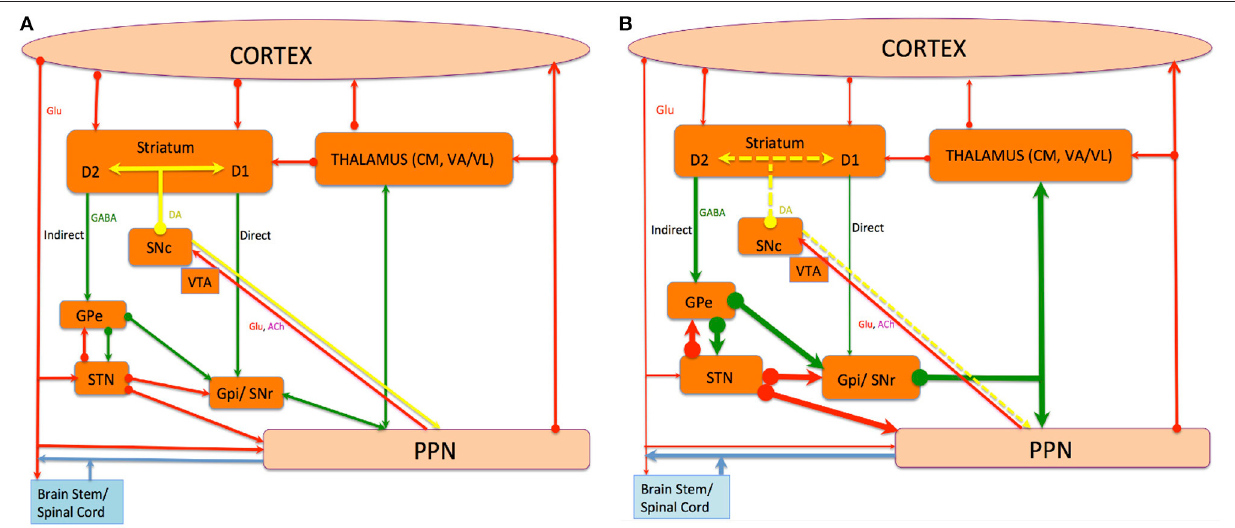
FIGURE 1 | The connections of The PPN, and the direct and indirect pathway of BG-thalamocortical circuits under normal (A) and PD (B) conditions. Red, green, and yellow lines denote glutamatergic, GABAergic and dopaminergic projections respectively, while blue lines indicate chemically amalgamated projections. Thickening lines show increased activity whereas thinning lines show decreased activity when alterations occur in the average activity rate of specific projection pathways in PD compared with the normal state. Dotted yellow lines indicate loss. The striatum and STN deliver input from incoming cortical information to the BG. The GPi and SNr deliver output information from the BG to the rest of the brain and apply robust inhibitory control on targets in the thalamus and the brainstem. This tonic inhibitory input must be disinhibited to permit normal movements to occur. The striatum applies opposite influences on the GPi and SNr via two distinct classes of efferent neurons, namely the D1-receptor-rich “direct pathway” positively modulated by DA and the D2-receptor-rich “indirect pathway” negatively modulated by DA. The loss of DA in PD’s causes disequilibrium in the activity of these two striatofugal pathways and their corresponding cortical